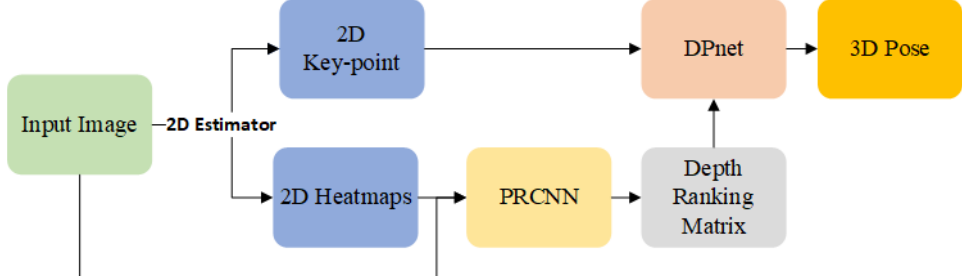
Figure 6. Illustration of Wang’s two-stage approach based on depth ranking.